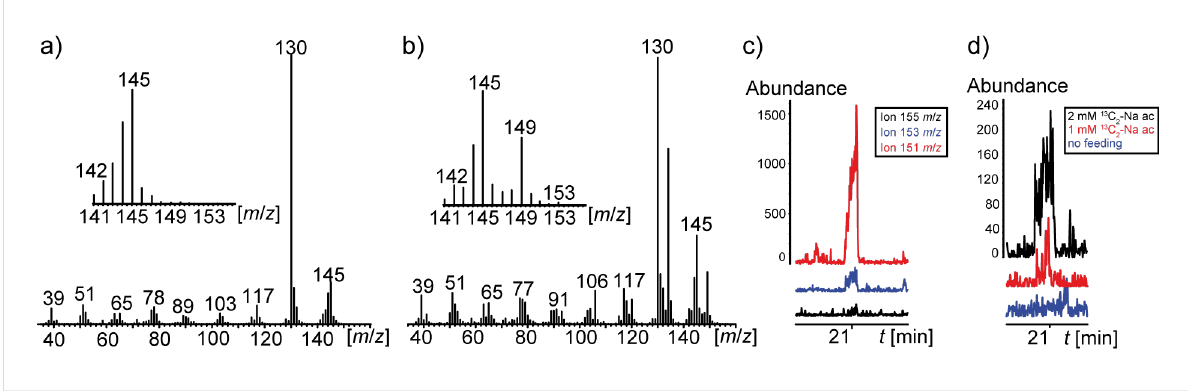
Figure 6: a) Mass spectrum of streptopyridine A ( 12 ), b) mass spectrum of 12 after feeding of 2 mM 13 C 2 -sodium acetate, c) single ion chro- matogram of 151, 153, 155 m / z after feeding with 2 mM 13 C 2 -sodium acetate; d) single ion chromatogram of the 153 m / z molecular ion after feeding with 2 mM 13 C 2 -acetate, 1 mM sodium 13 C 2 -acetate, and a non fed culture as comparison. The ions at m/z 151, 153, and 155 indicate the incorpor- ation of three, four, or five 13 C 2 -acetate